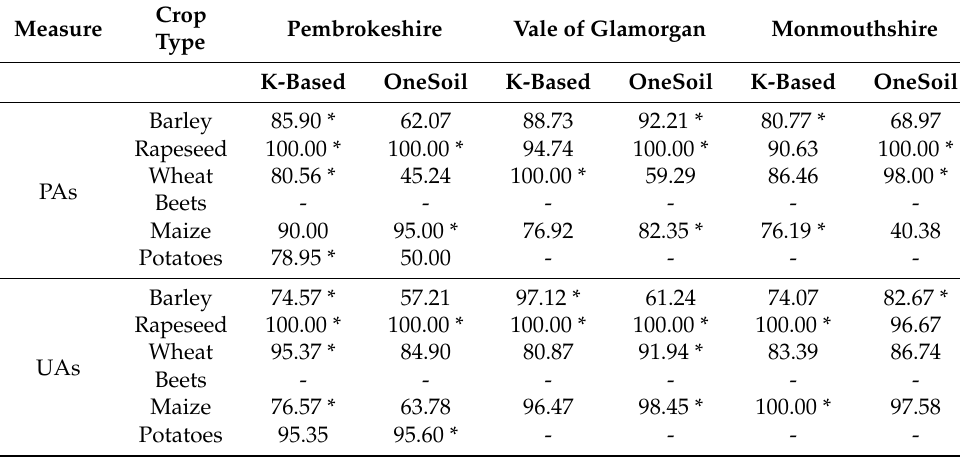
Table 5. Producer accuracies (PAs) and user accuracies (UAs) in% for the new (K-based) and OneSoil maps over Pembrokeshire, Vale of Glamorgan, and